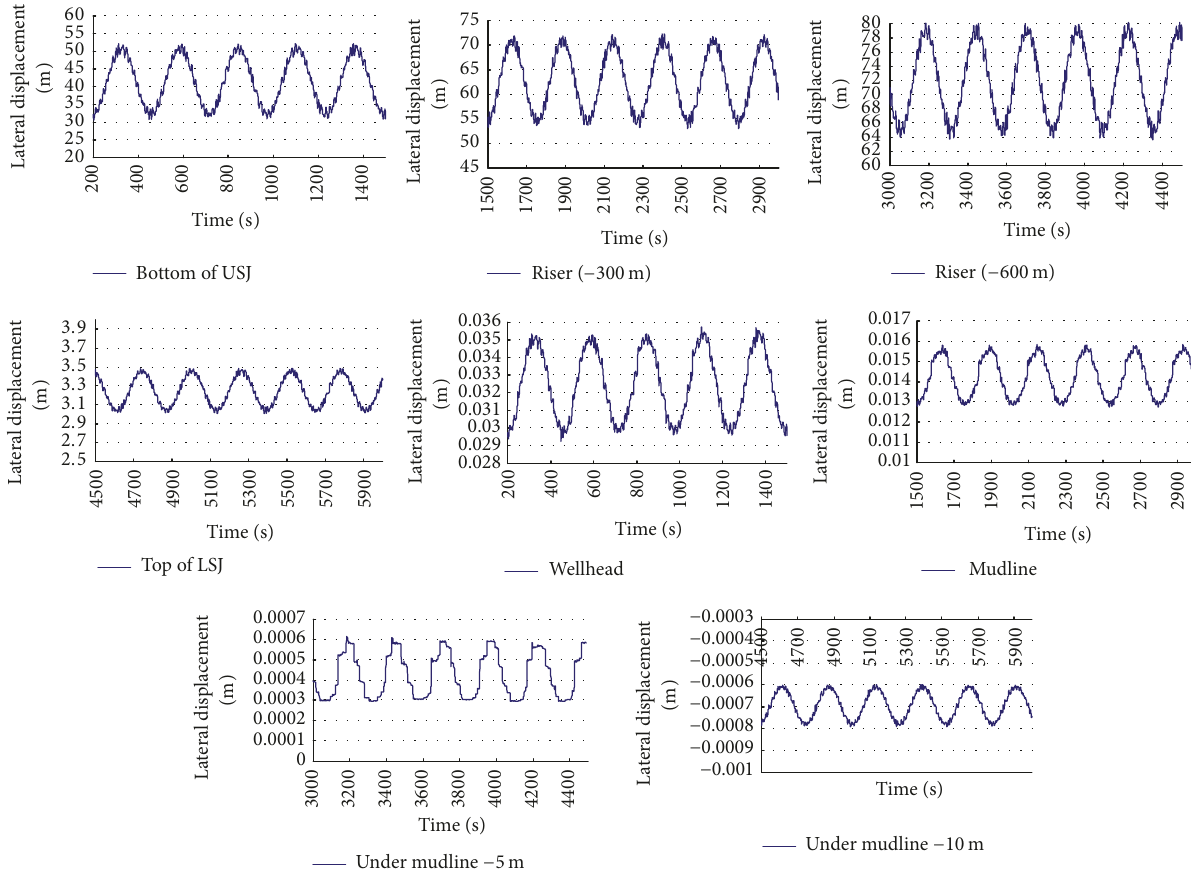
Figure 7: Lateral displacement at different